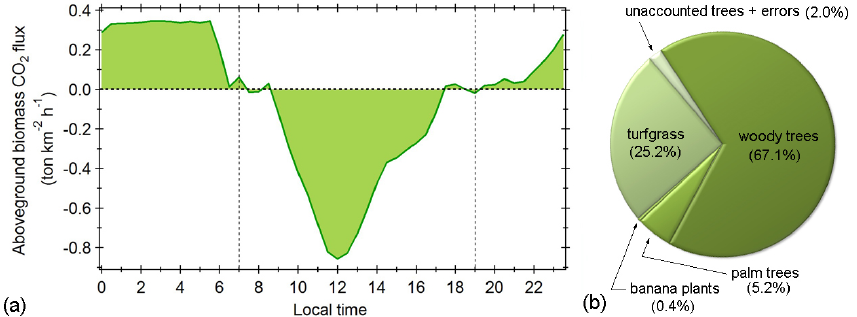
Fig. 6. (a) Diurnal pattern of aboveground biomass CO 2 flux calculated as the difference between total CO 2 fluxes directly measured by EC and estimated emissions from bottom up approach. Positive and negative fluxes represent emissions from dark respiration and sequestration by photosynthesis, respectively. The aboveground biomass flux during the light transition periods (i.e. just before and after sunrise and sunset indicated by vertical dotted lines) is essentially zero. (b) Partitioning of CO 2 assimilated by type of vegetation: woody trees contribute two thirds of the total followed by turfgrass, palm trees and other plants (e.g. banana). Data are for a residential area (Telok Kurau,